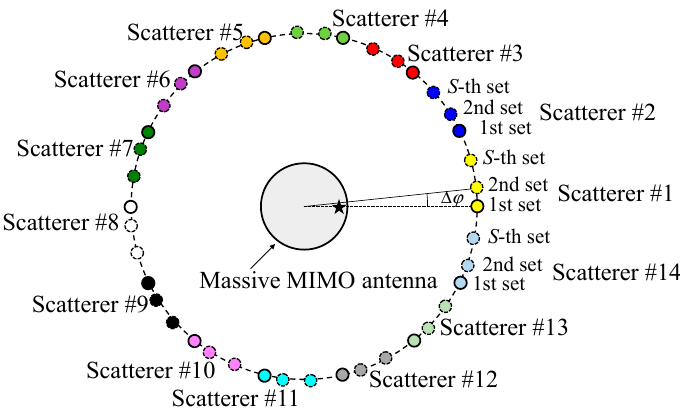
Figure 1. Configuration of the scatterers for evaluating the massive MIMO system.